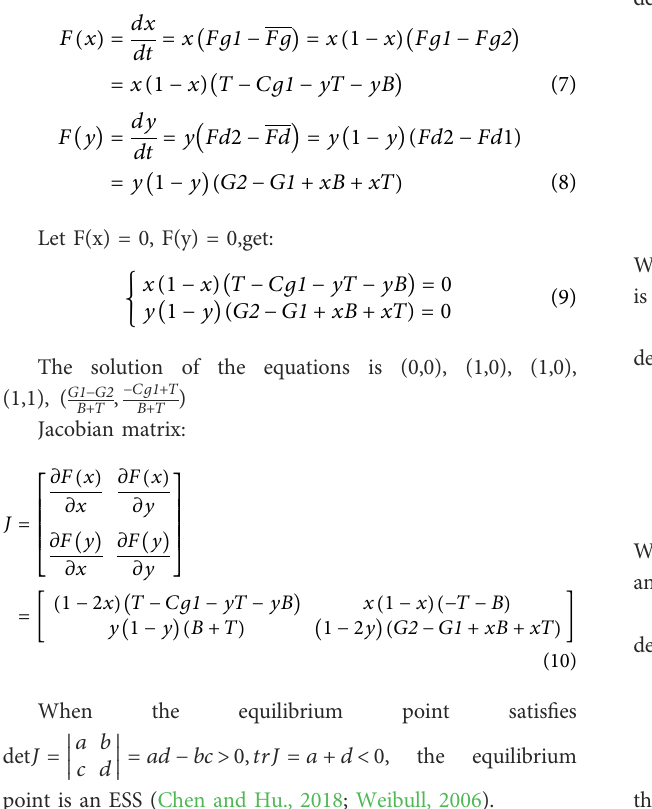
The replication dynamic equation of government regulation and property developers implementing low-carbon houses is: